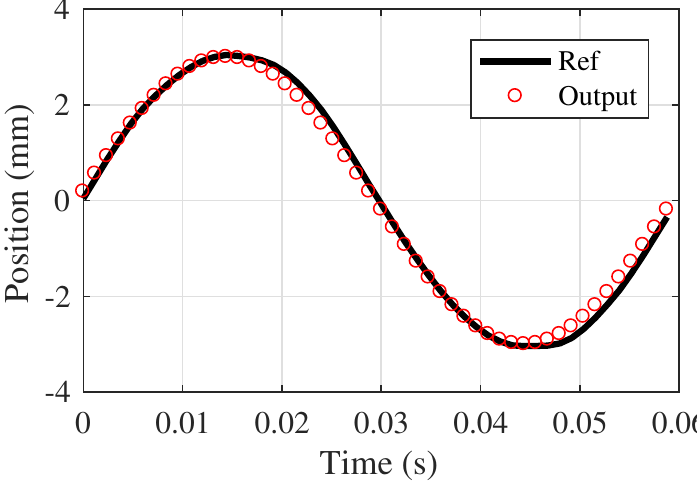
Figure 30. Experiment of PID. The working frequency is set as 24 Hz and waveforms of current and position for one operating point of AMFC are shown in Figures 31 and 32.